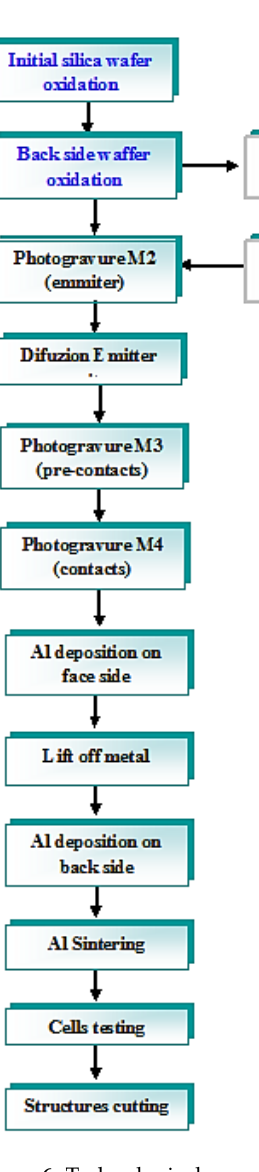
Figure 6. Technological process of photovoltaic cells manufacturing.